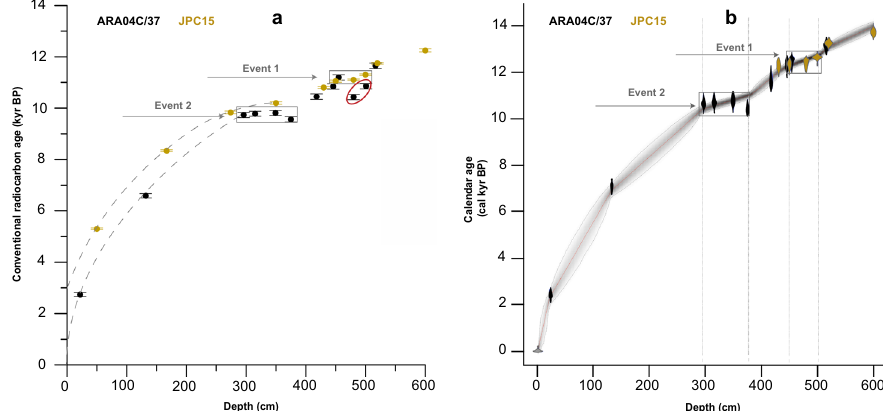
Fig. 4 Chronology. a uncalibrated AMS 14 C dates of Core ARA04C/37 (black dots) and Core JPC15 19 (brown dots). The vertical error bars represent the 1 sigma analytical errors. Blue boxes mark two intervals characterized by nearly constant ages, possibly related to two events. Red circle shows the excluded “ outliers ” of Core ARA04C/37. b Age – depth model based on Bacon 87 combines ten AMS 14 C dates from Core ARA04C/37 (black) and six AMS 14 C dates from Core JPC15 (brown) 19